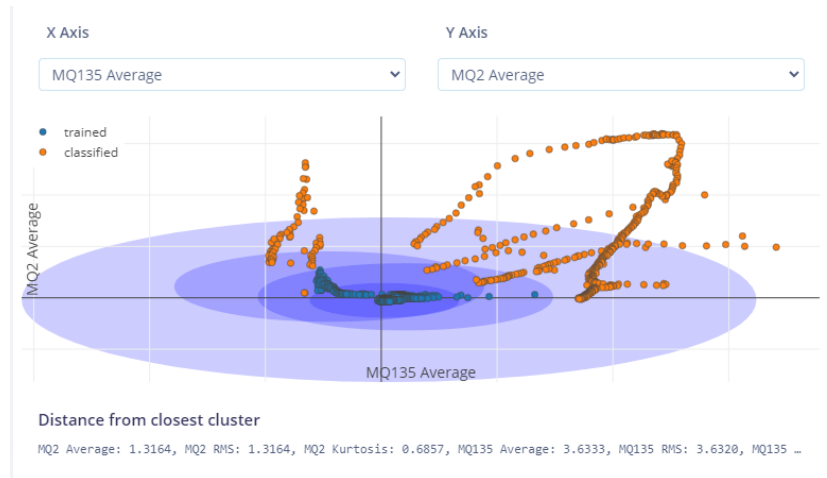
Figure 5. Data Visualization related to sensors’